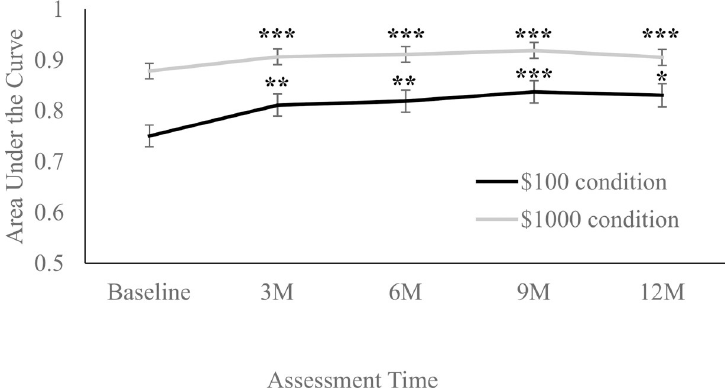
Fig 4. Model-estimated averages (mean ± SE) of delay discounting (calculated via area under the curve) at each assessment point, for both $100 and $1000 conditions. Legend: M = Month. ��� indicates p < .001, �� indicates p < .01, and � indicates p < .05, compared to baseline. Higher Areas Under the Curve (AUCs) represent less discounting (and thus less